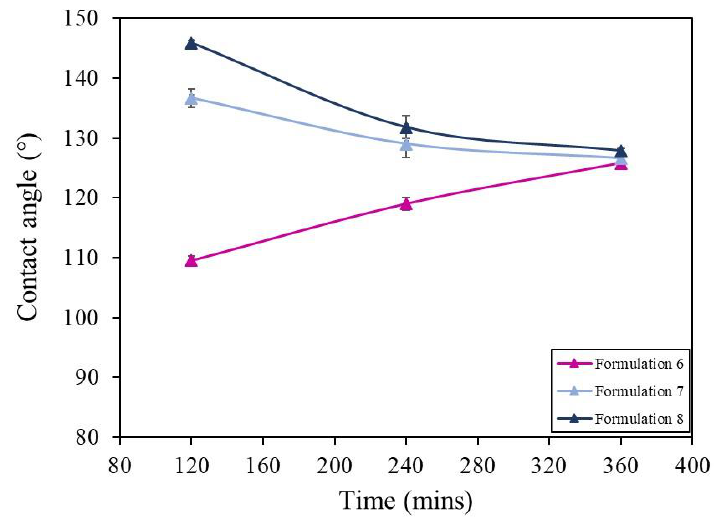
Figure 6. Relationship between CA against immersion time for formulations 6 – 8 from Table 1.